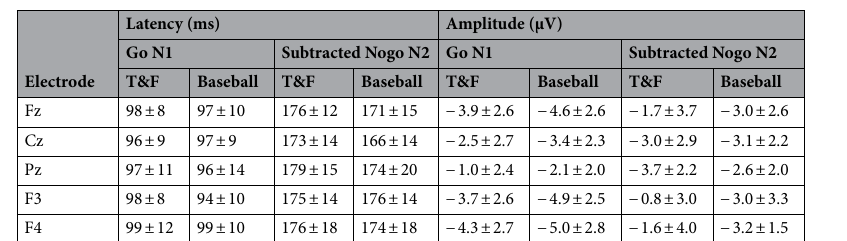
Absence of changes in auditory ERP component. Figure 2A shows the grand averaged waveforms at five electrode positions in auditory Go trials for the baseball and T&F groups, and Fig. 2B presents the grand averaged subtracted Nogo N2 for each electrode position and both groups obtained as described for the soma- tosensory Go/Nogo sessions. The peak latencies and amplitudes of N1 and subtracted Nogo N2 at the five elec- trode sites for both groups are presented in Table 2. Two-way ANOVA revealed no significant main effect of electrode or group and no group × electrode position interaction on the latency of N1 and subtracted Nogo N2.